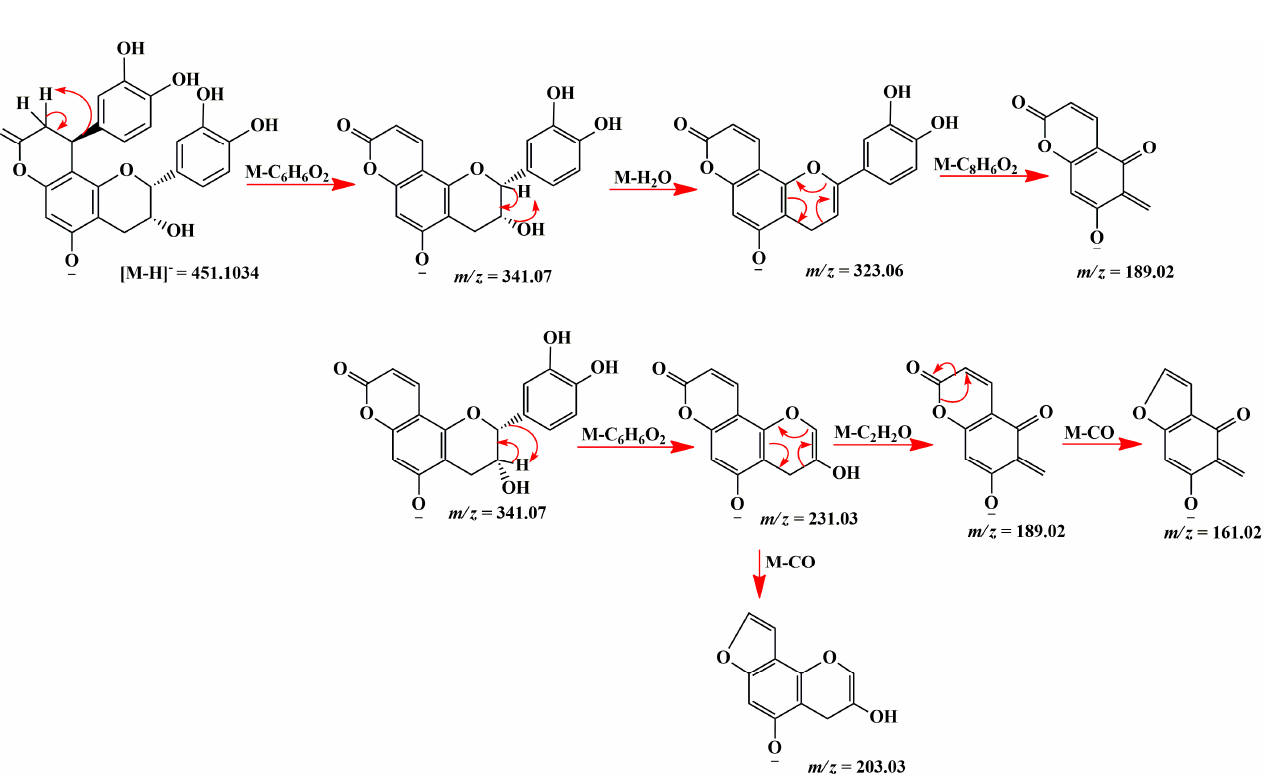
Figure 6. Proposed fragmentation mechanism of cinchonain Ib ( 33 ) from the A. uleanus and T. catigua crude extracts. 52